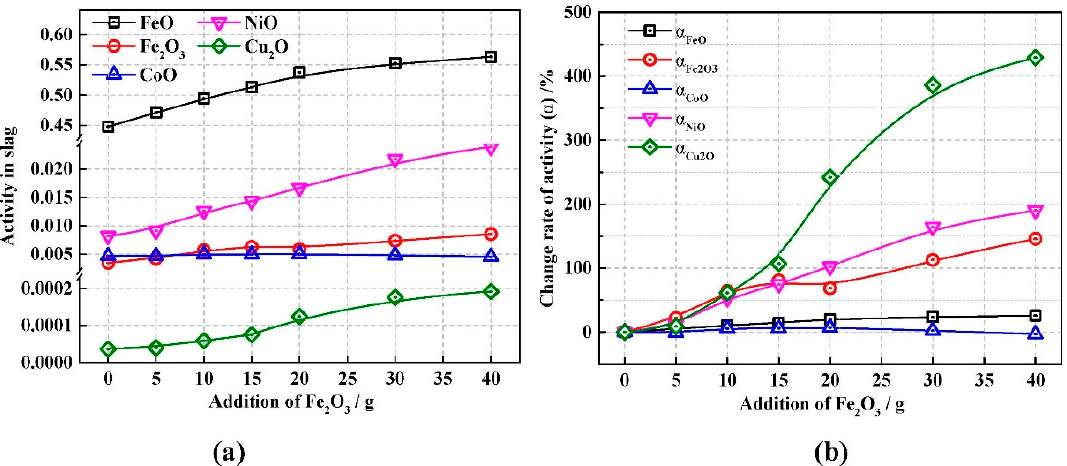
Figure 5. Addition of Fe 2 O 3 versus ( a ) activity of oxides, and ( b ) activity change rate of oxides.